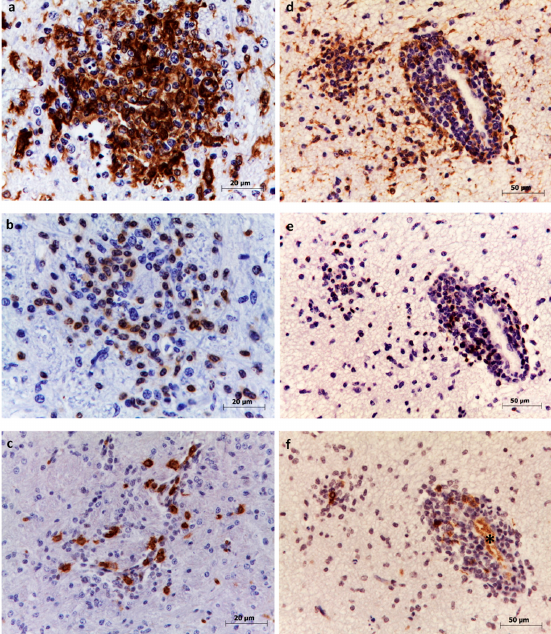
Figure 2. Immunohistochemistry to detect microglia, T lymphocytes, and B lymphocytes in thalamus ( a – c ) and hippocampus ( d – f ). Microglia were identified based on labeling with anti-Iba1 antibodies. Abundant cells are visible within glial foci ( a ) and in the perivascular infiltrate ( d ). T lymphocytes were identified based on labeling with anti-CD3 antibodies. Moderate numbers are visible in the glial focus ( b ) and in the perivascular cuff ( e ). B lymphocytes were identified based on labeling with anti-CD20 antibodies. Few numbers are visible within the glial focus ( c ) and perivascular infiltrate ( f ). Erythrocytes were also immunolabelled (asterisk) but were not included in the counting. Table 2. Proportion (%) of all immunostained cells, i.e., microglia, T or B lymphocytes, or astrocytes, in lambs experimentally infected with SGEV, stratified according to lesion severity, central nervous system (CNS) region, and lesion type.